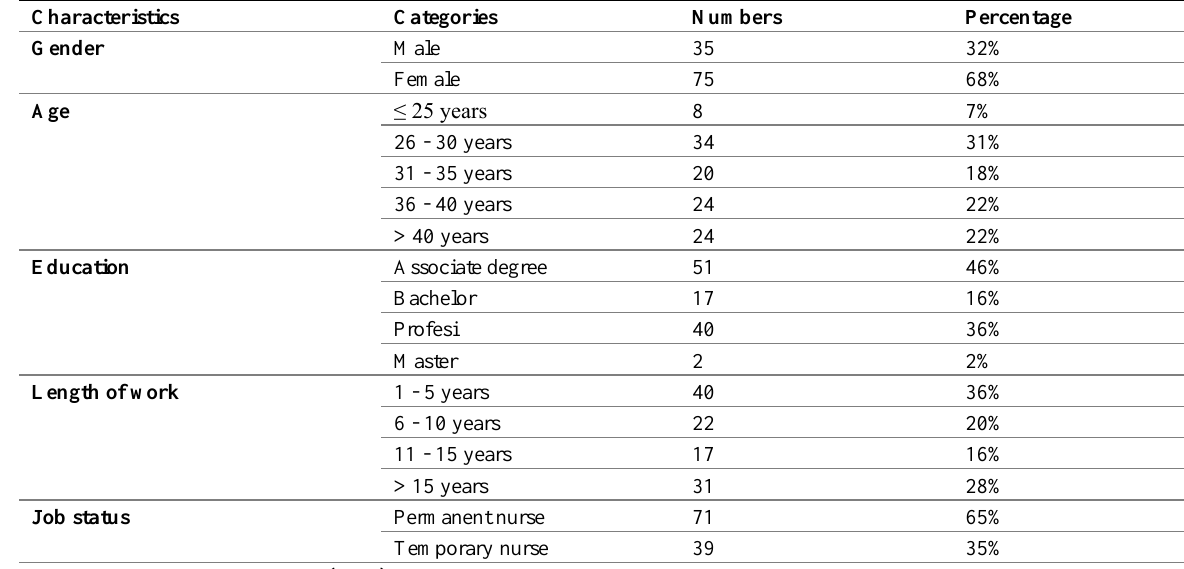
Table 1: Characteristics of